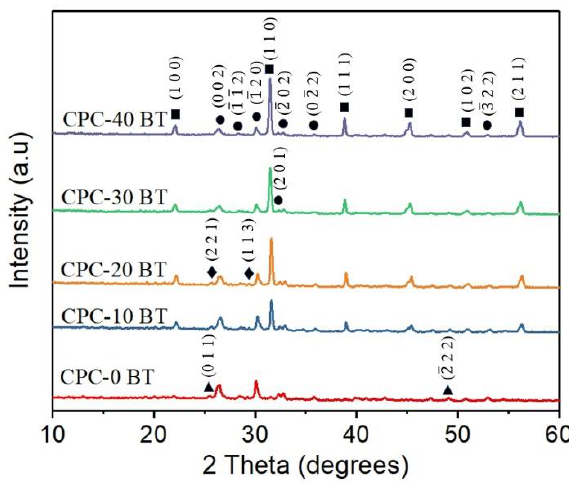
Figure 2. X-ray diffraction (XRD) patterns of CPC with various wt % BaTiO 3 (‘ ∎ ’ represents barium titanate (BT), ‘●’ represents monetite, ‘ ♦ ’ represents newberyite and ‘ ▲ ’ represents Ca(H 2 PO 4 ) 2 ).